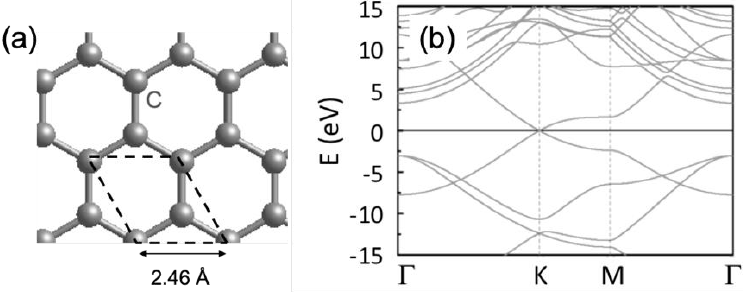
Figure 3. ( a ) Top view of the atomic configuration of graphene. ( b ) Computed electronic band structure of graphene. The Fermi level corresponds to the reference (zero energy) level.